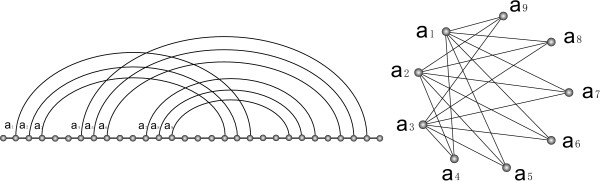
Skeleton and its L-graph. We display a skeleton (left) and its L-graph (right).